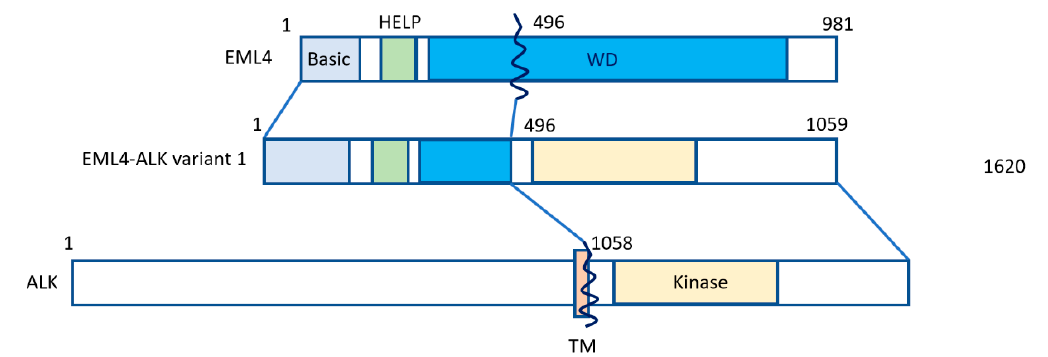
Figure 1. The EML4-ALK fusion gene. The N-terminal portion of EML4 is fused, containing the main region of EML4-ALK, i.e., the echinoderm microtubule-associated protein-like protein (HELP) domain, and part of the WD-repeat region to the intracellular region of ALK, which contains the tyrosine kinase domain. The transmembrane (TM) domain is not part of the final fusion product. Reproduced from Golding et al. [11].